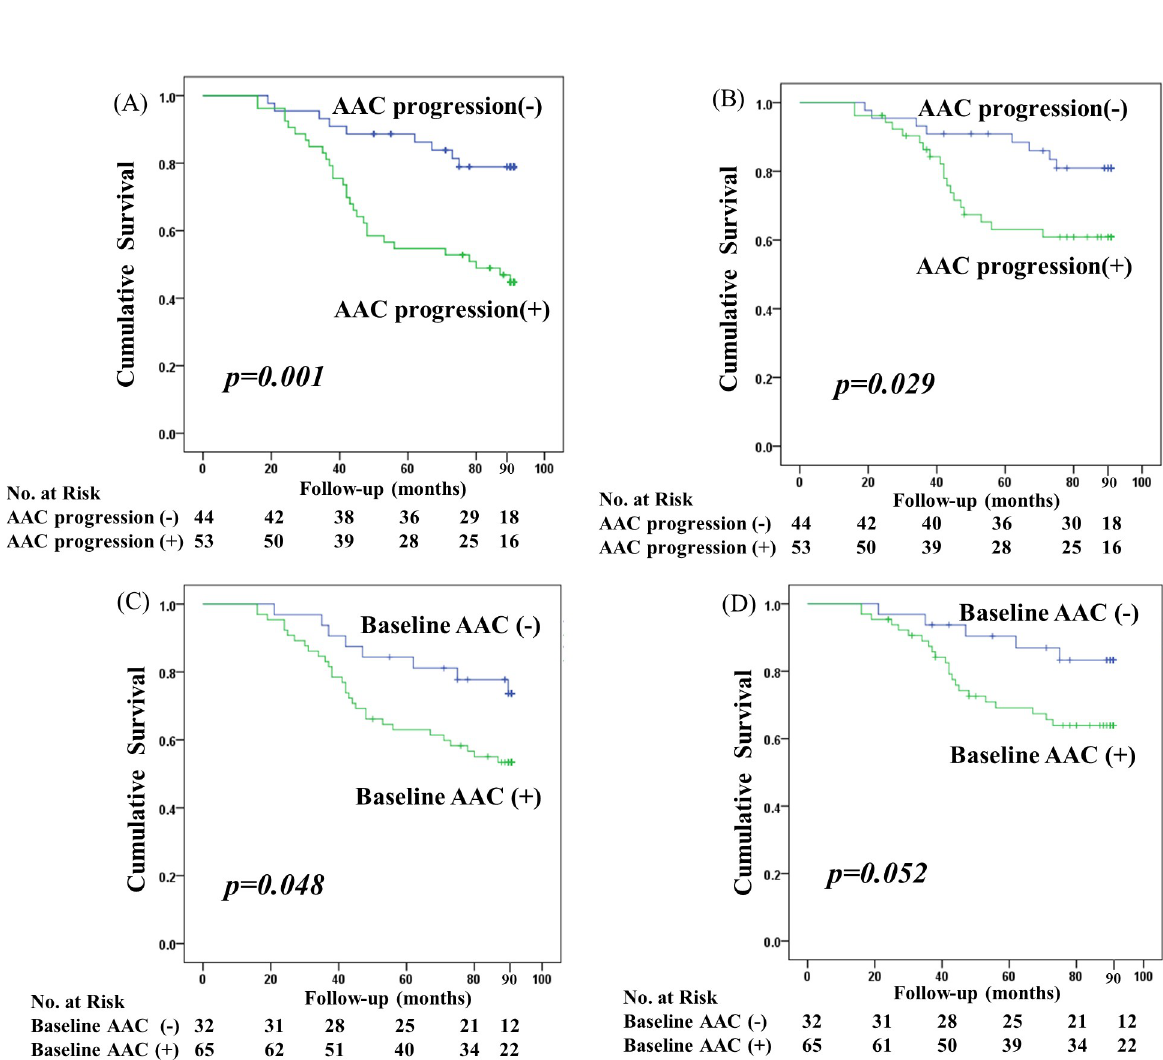
Fig 3. Survival curves for all-cause and cardiovascular mortality. (A) All-cause mortality according to AAC progression. (B) Cardiovascular mortality according to AAC progression. (C) All-cause mortality according to baseline AAC. (D) Cardiovascular mortality according to baseline AAC. The 7.5-year overall survival was significantly lower in patients with AAC progression (45.3% vs. 79.5%) as well as baseline AAC (53.8% vs. 75.0%) than in those without.